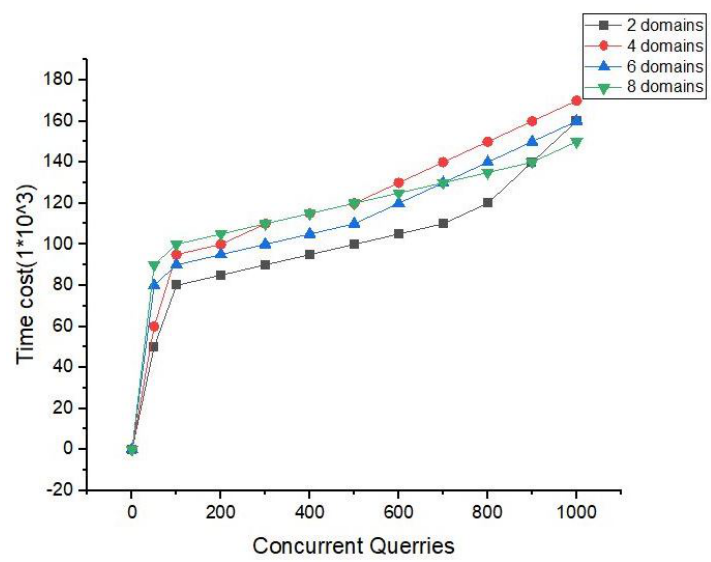
Figure 17. Efficiency analysis of our proposed method in different domains.